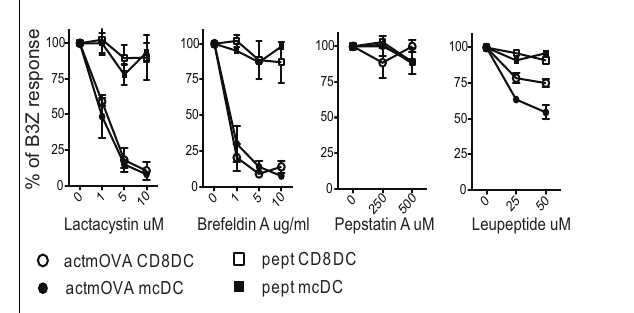
FIGURE 4 | Proteasomal inhibitors effectively block cross-presentation in both CD8 α DC and mcDC. Splenic DC were incubated with irradiated actmOVA cells in the presence of indicated inhibitors. After 20h, samples were fixed, sorted, and cultured with OVA-specific B3ZT cells to assess the cross-presentation of cell-associated antigens. Cells pulsed with OVA 257–264 prior to fixation were used to demonstrate priming capacity. Responses are normalized to control